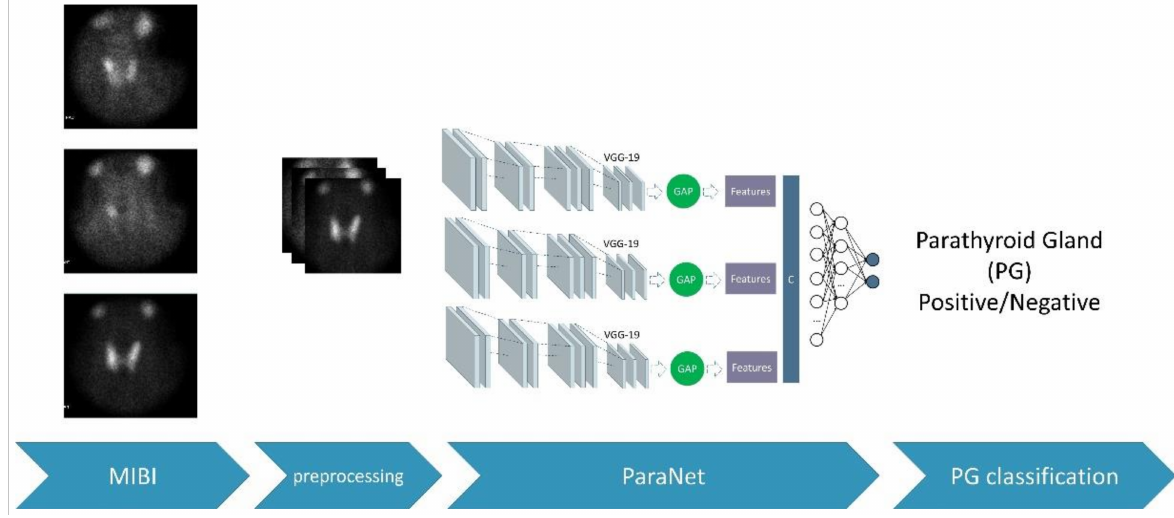
Figure 3. The overall